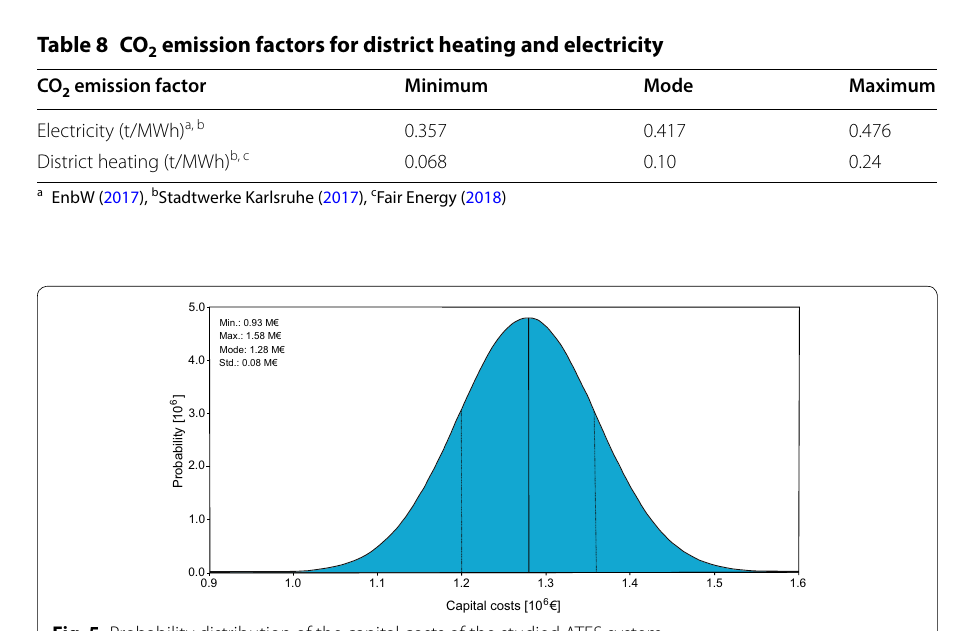
Fig. 5 Probability distribution of the capital costs of the studied ATES